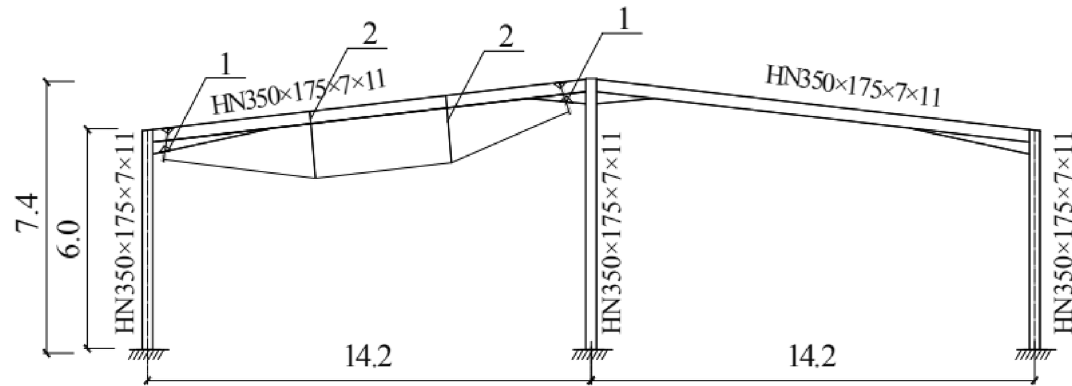
Fig. 3 Portal frame model: 1. End anchorage, 2. Loading strut